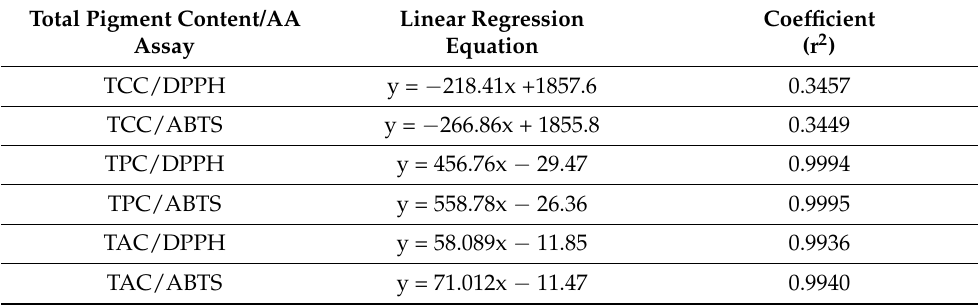
Table 5. Correlation by linear regression between total pigment contents and AA. Total Pigment